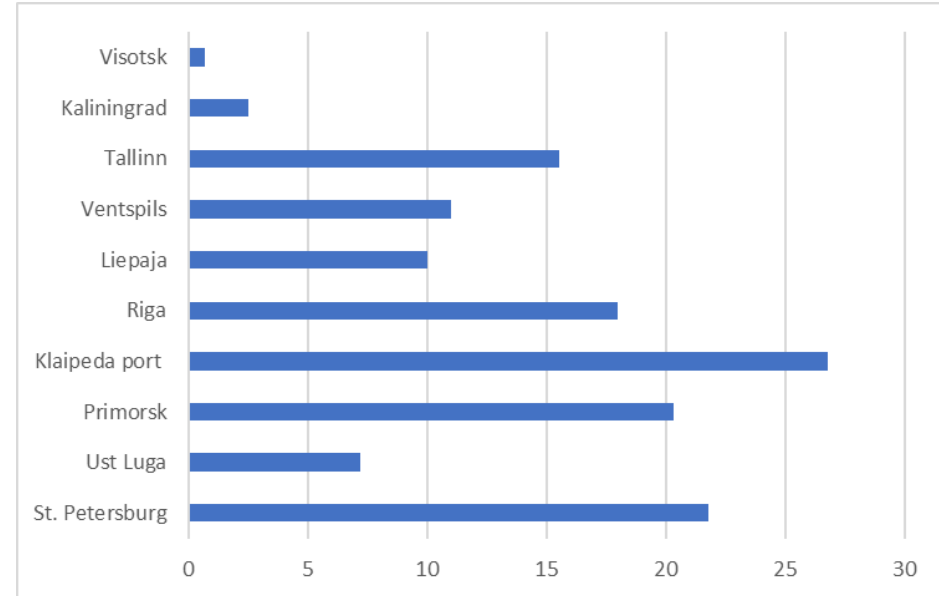
Figure 14. Maximum port depth (meters).